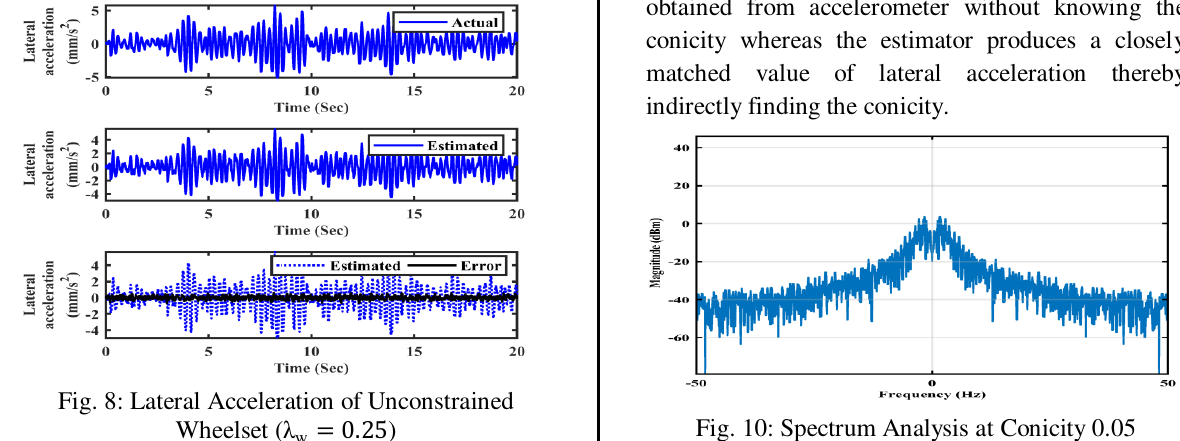
Fig. 7: Lateral Acceleration of Unconstrained Wheelset ( λ ) w = 0.2